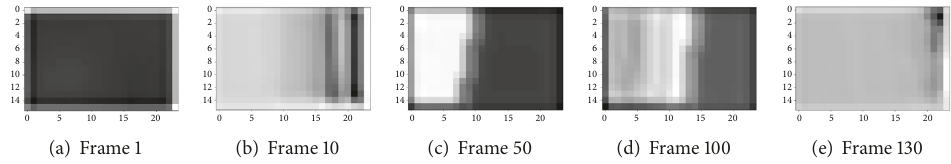
Figure 4: Predicted Images after